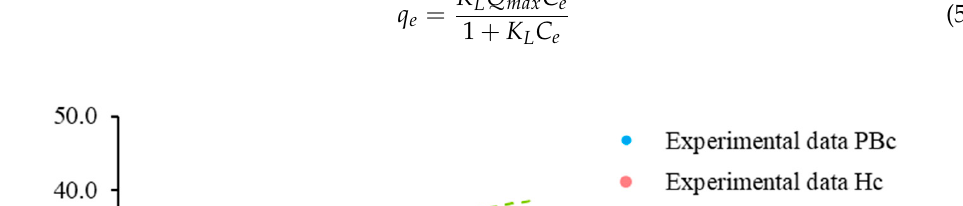
Table 3. Parameters obtained from equilibrium model fittings (value ± standard error of the coeffi- cient).